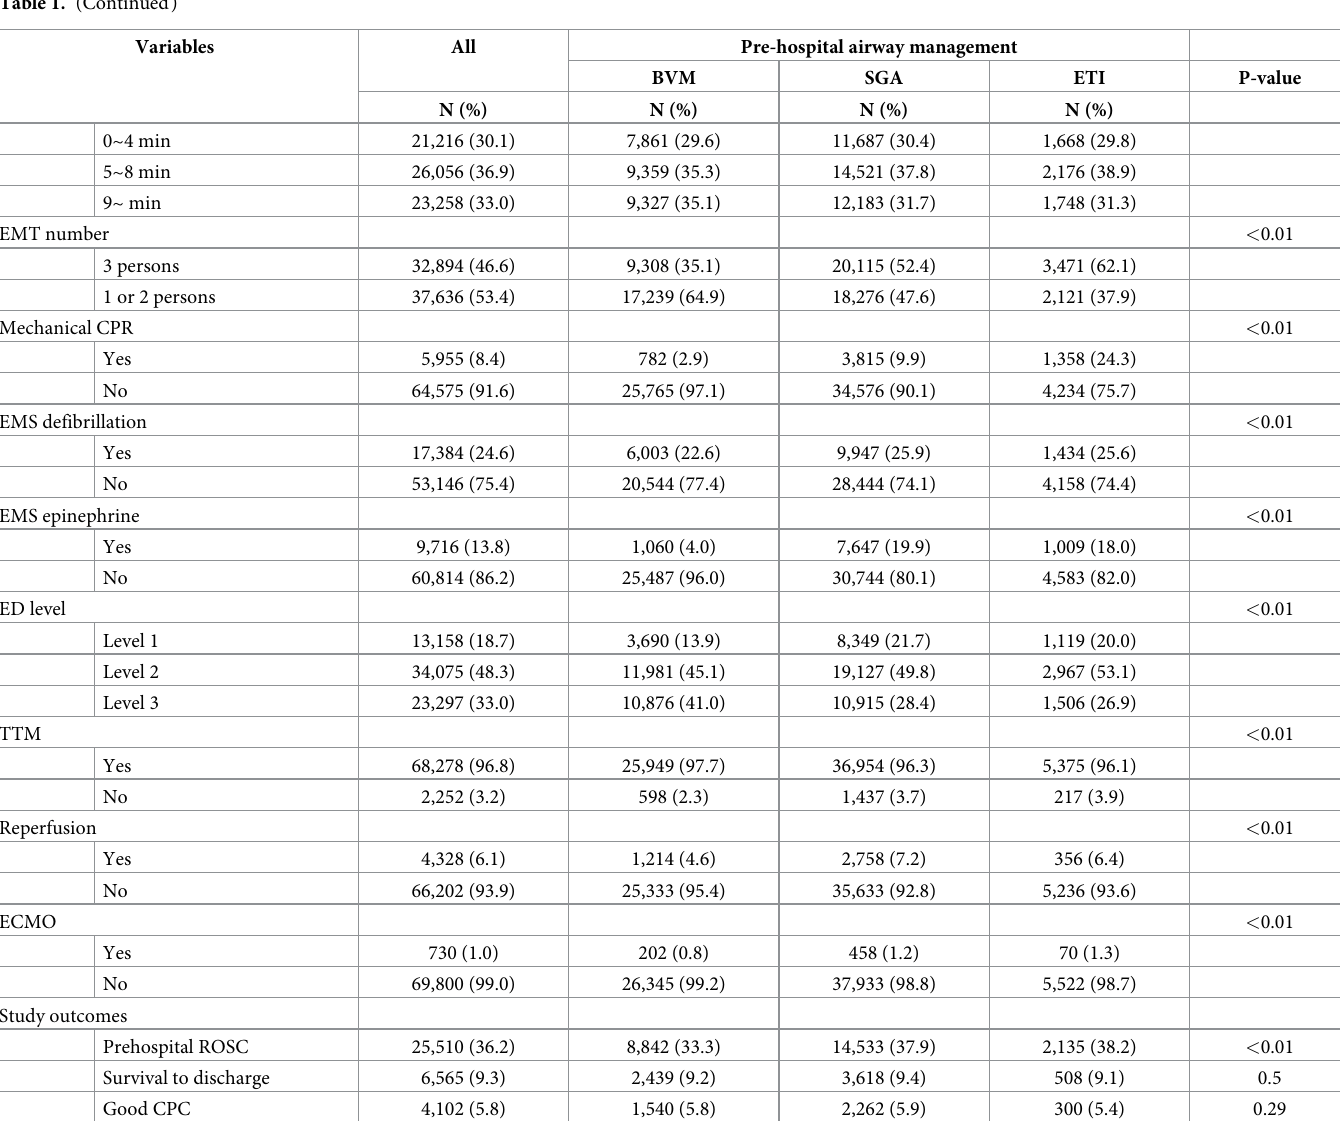
groups. There were a total of 1,198 (21.4%) survival to discharge patients in the ETI group, 8,590 (22.4%) in SGA group, and 5,537 (20.9%) in BVM group (p < 0.01). There was no signif- icant difference in the neurological recovery across the airway intervention techniques. The demographics of OHCA patients by TTI are summarized in Table 2. Patients with longer TTI (more than 8 minutes) were more likely to be from the non-met- ropolitan areas, had initial shockable rhythms in ECG, had fewer number of EMT members who attended to them, and were likely to be transported to level-1 ED. The survival to dis- charge was lower in patients with longer TTI, while the neurological recovery was